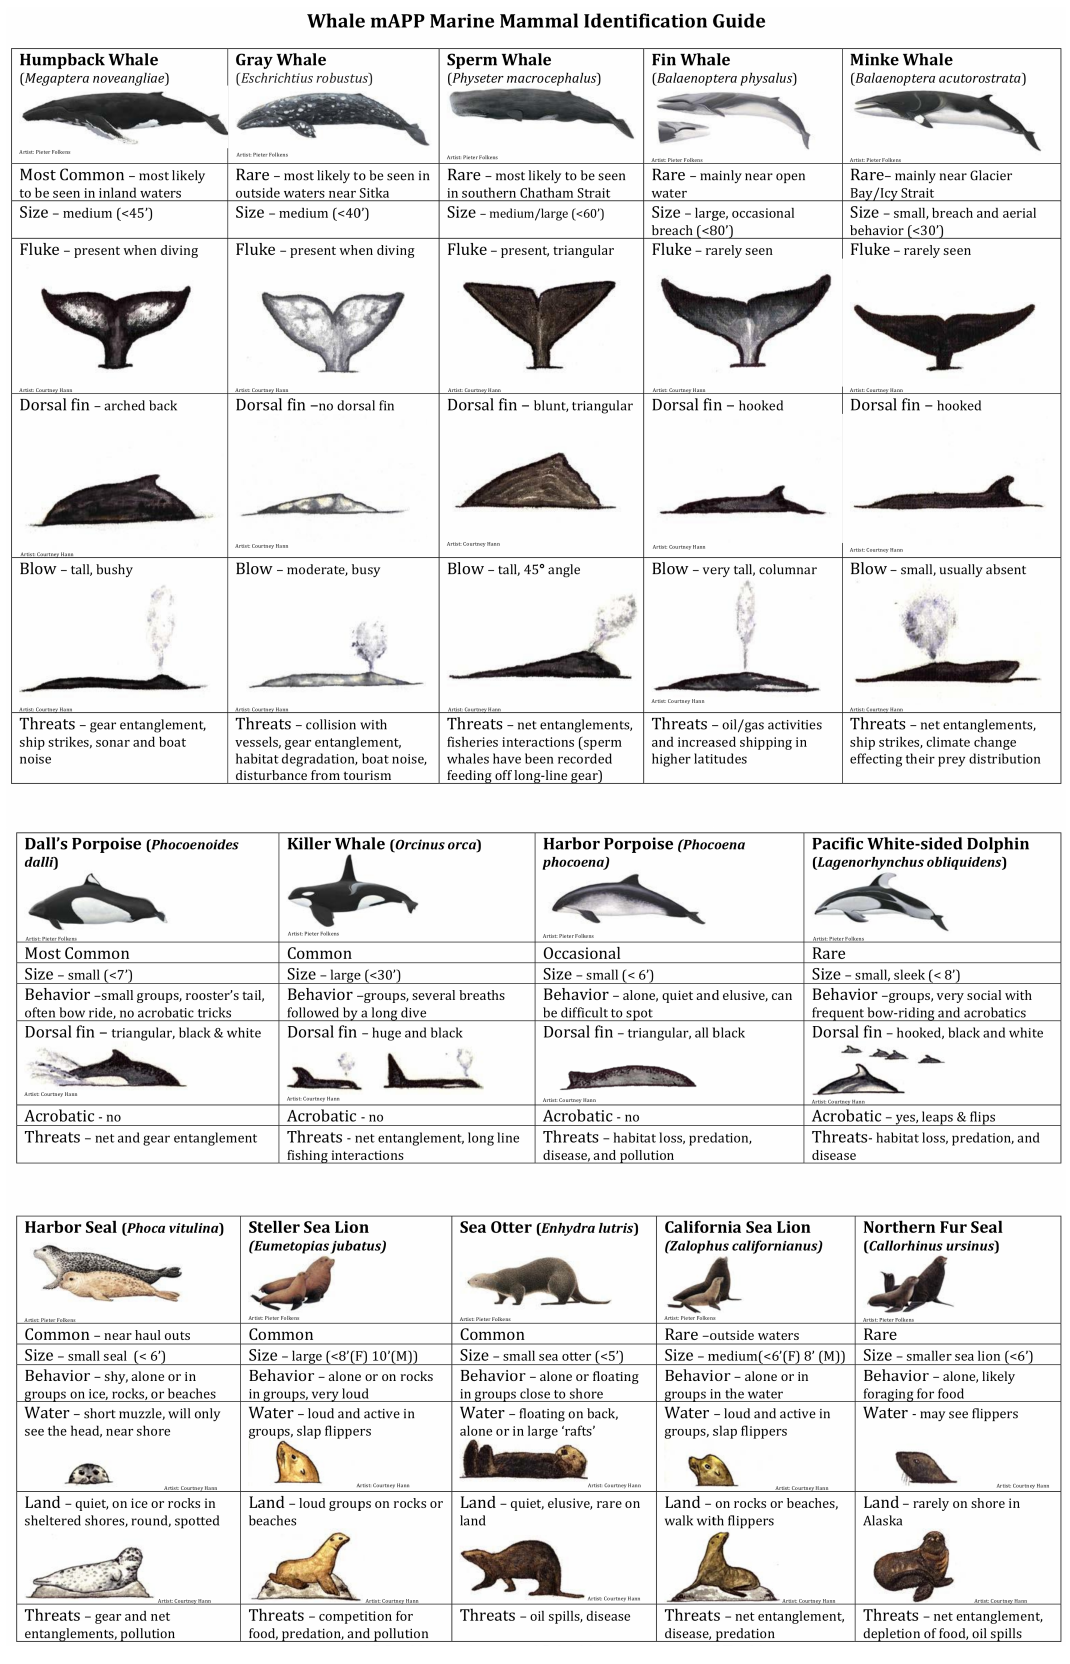
Figure 3. Marine mammal identification guide for common marine mammals in Southeast